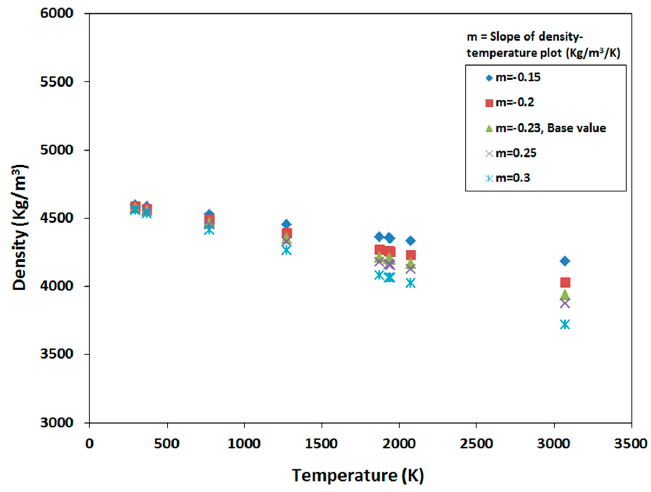
Figure 8. Density vs temperature plot with varying slopes .